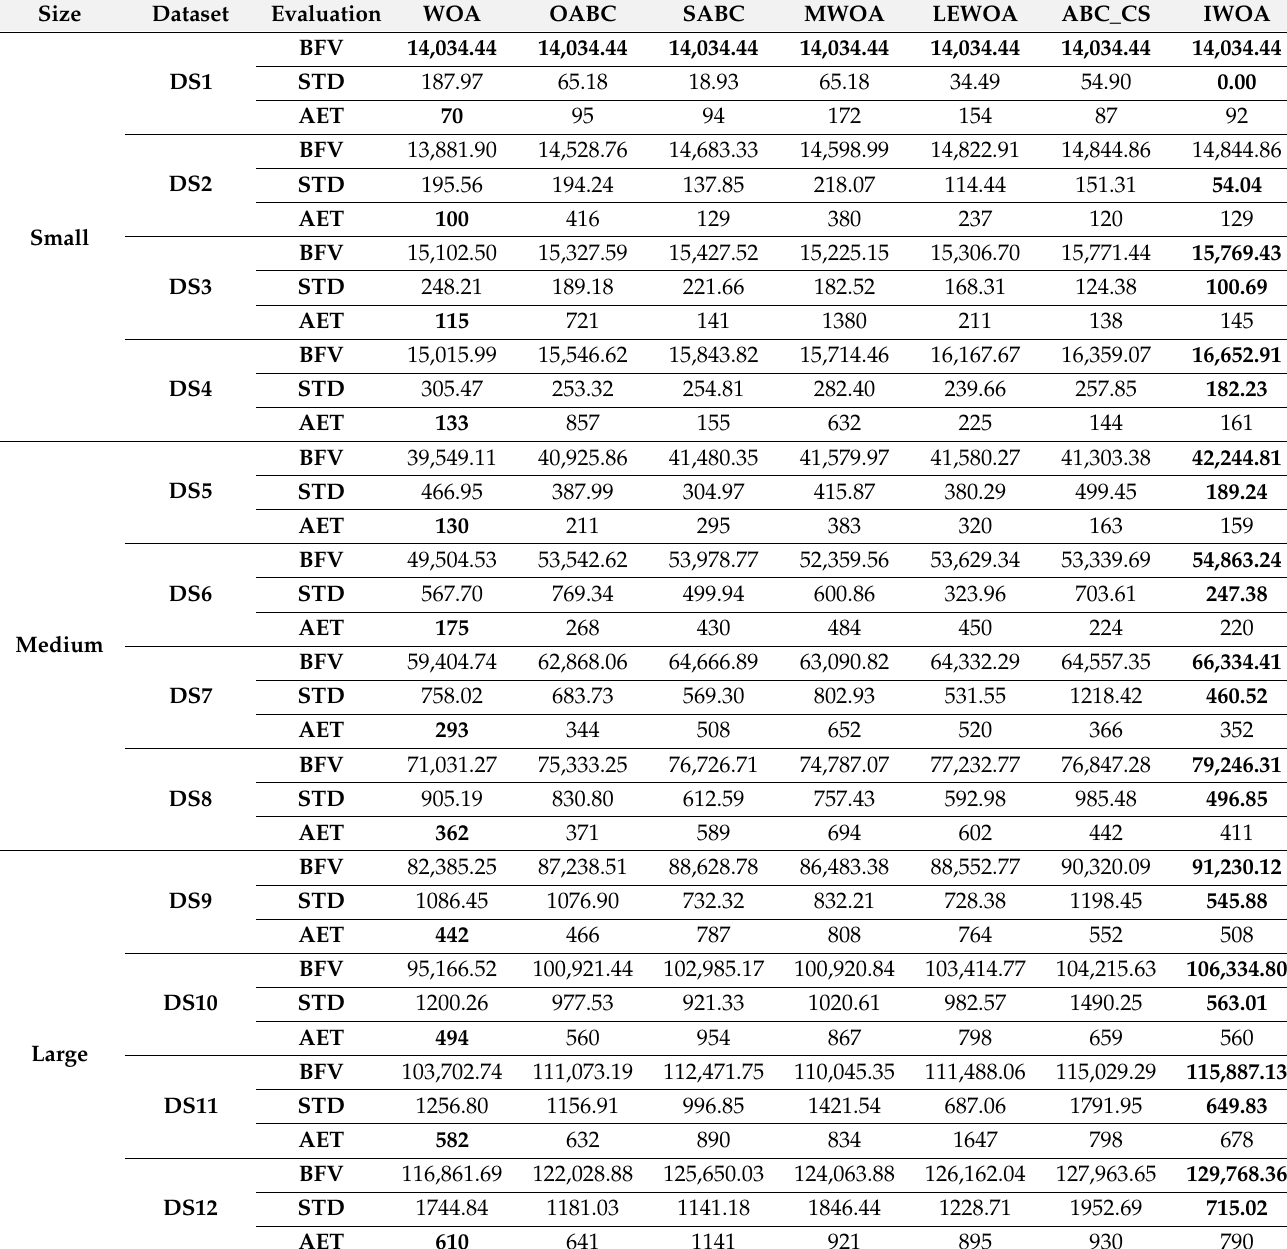
Table 3. Best fitness values (BFV), standard deviation (STD), and average execution time (AET) values for IWOA compared to other